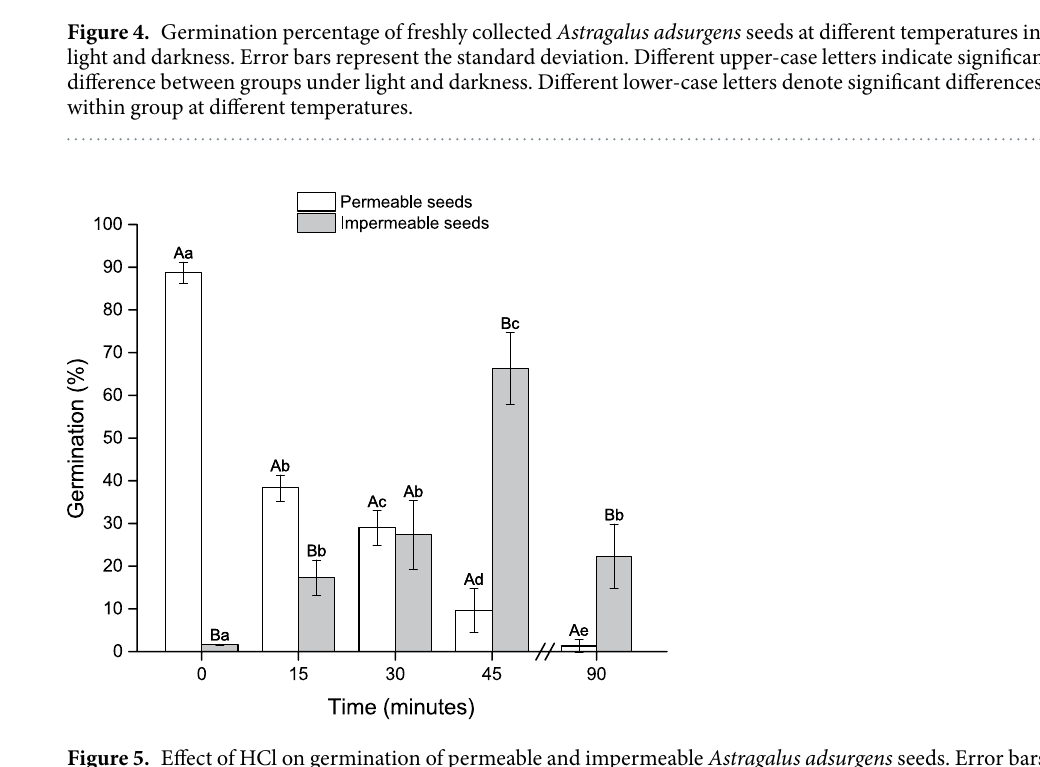
Figure 5. Effect of HCl on germination of permeable and impermeable Astragalus adsurgens seeds. Error bars represent the standard deviation. Different upper-case letters indicate significant differences between permeable and impermeable seeds. Different lower-case letters indicate significant differences within group for different treatment